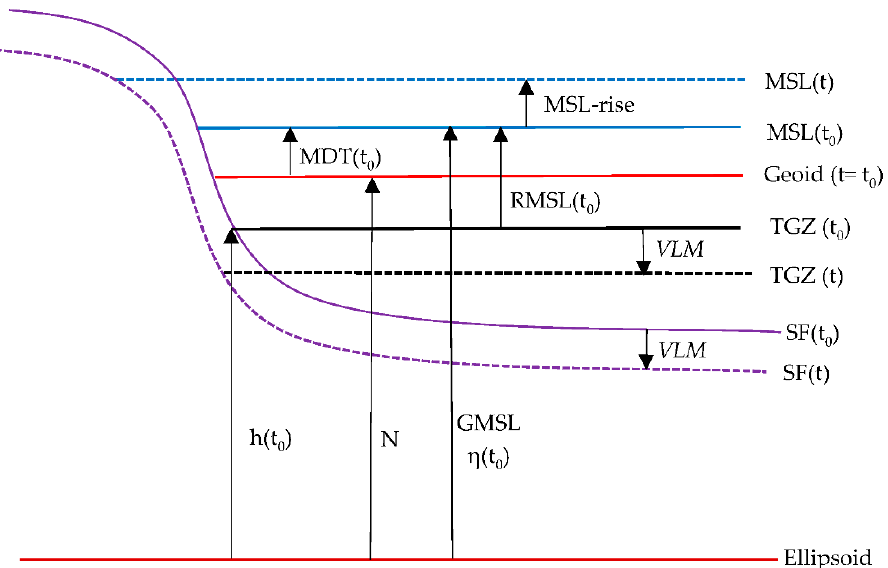
Figure 2. The time-dependent relationship between surfaces and MSL at a reference epoch, t 0 and epoch, t .